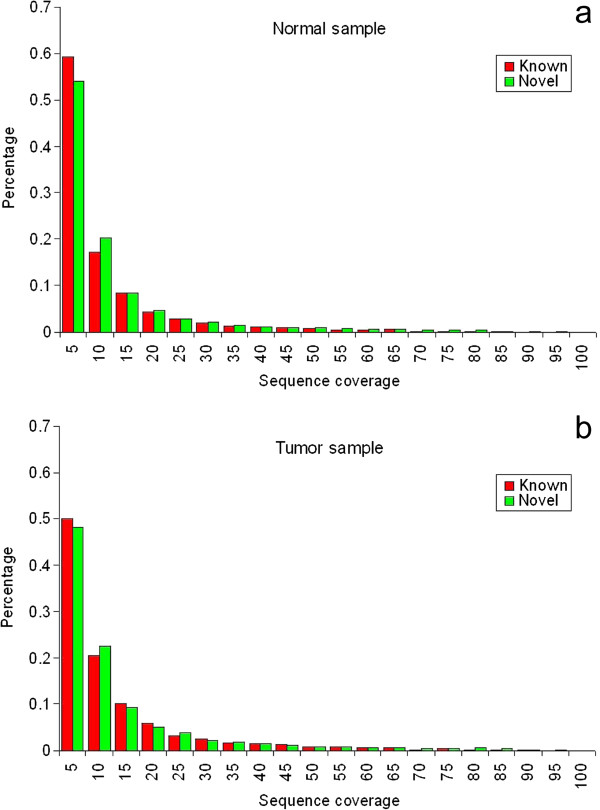
The distribution of sequence coverage for variant calling. Known variants are those found in dbSNP 135 database, and novel variants are those identified in this study. a. The pattern in normal samples. b. The pattern in tumor samples.